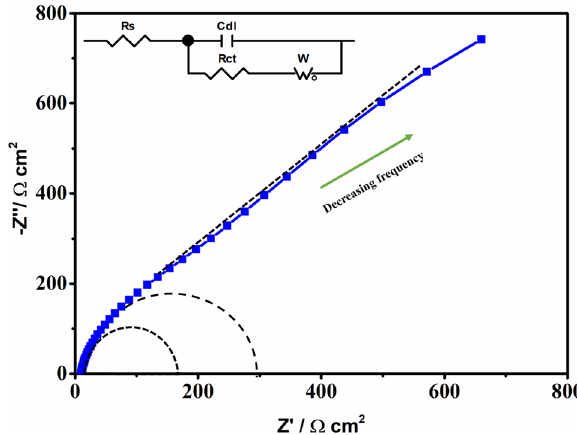
Figure 9. Nyquist plot of the prepared Cu 3 VSe 4 NSs-FTO thin film measured in 0.6 M KCl aqueous solution with pH of 4 at the 0.215 V potential vs